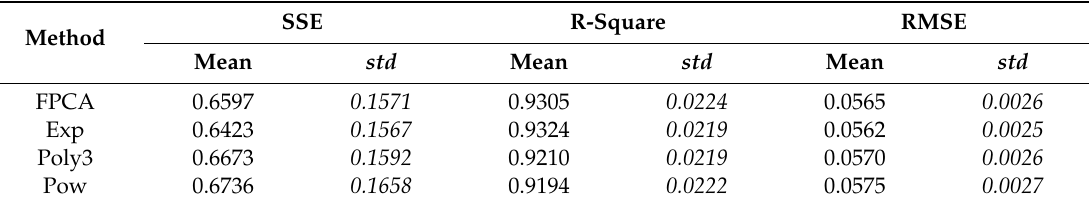
Figure 7. Degradation modeling for one engine: ( a ) the proposed functional principal component analysis (FPCA); ( b ) the fitting by Exponential; ( c ) the fitting by 3rd order polynomial; ( d ) the fitting by Power law. Table 4. Comparisons of the degradation modeling results. Abbreviations: SSE, sum of square error; R-square, the coefficient of determination; RMSE, root mean square error.